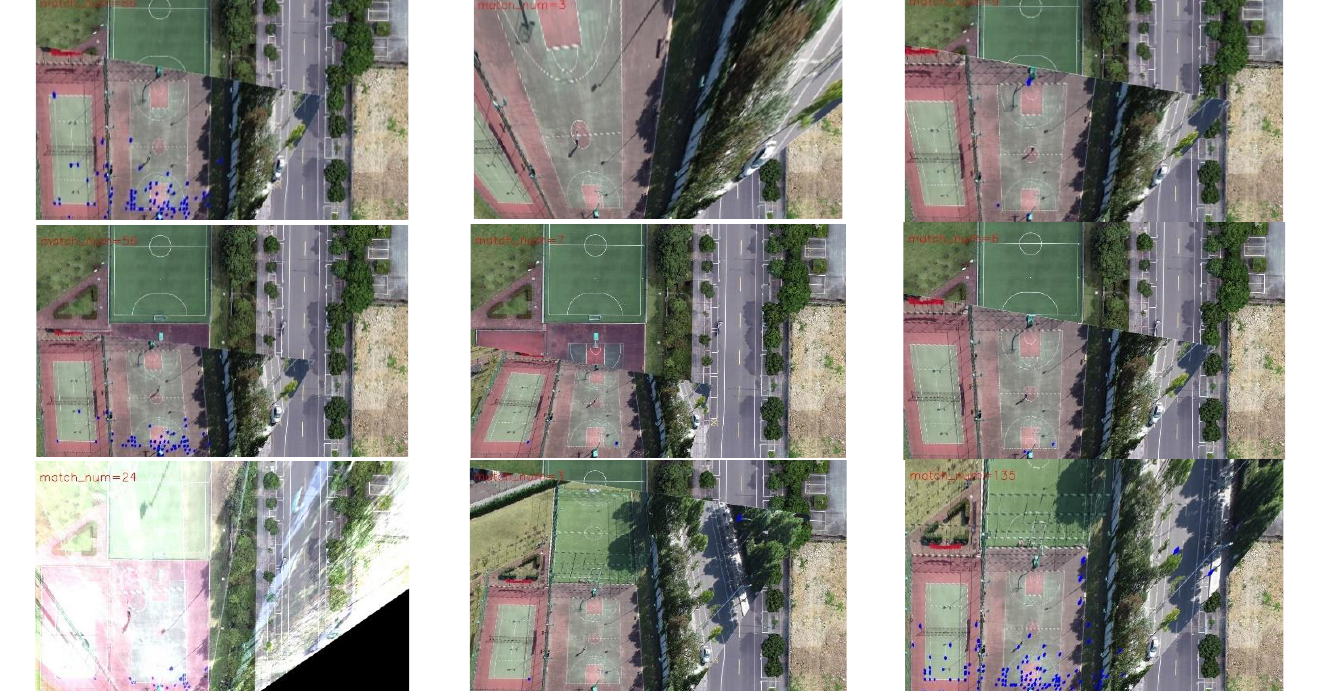
Figure 19. Registration image (without updating the map features).